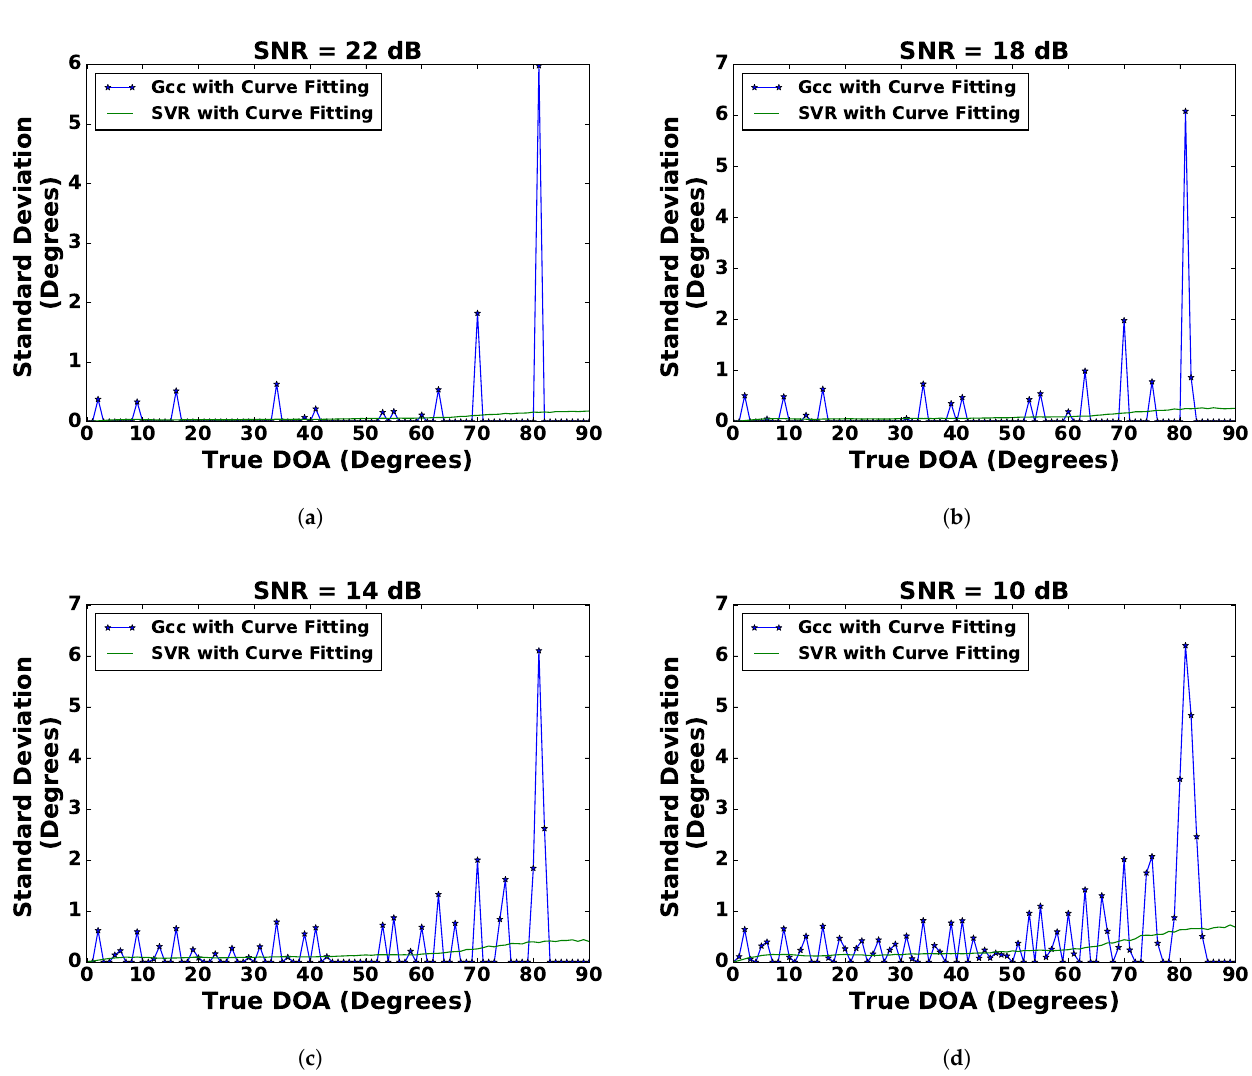
Figure 7. Comparison of the standard deviation of SVR with curve fitting (SVR-CF) and the GCC with curve fitting for ( a )